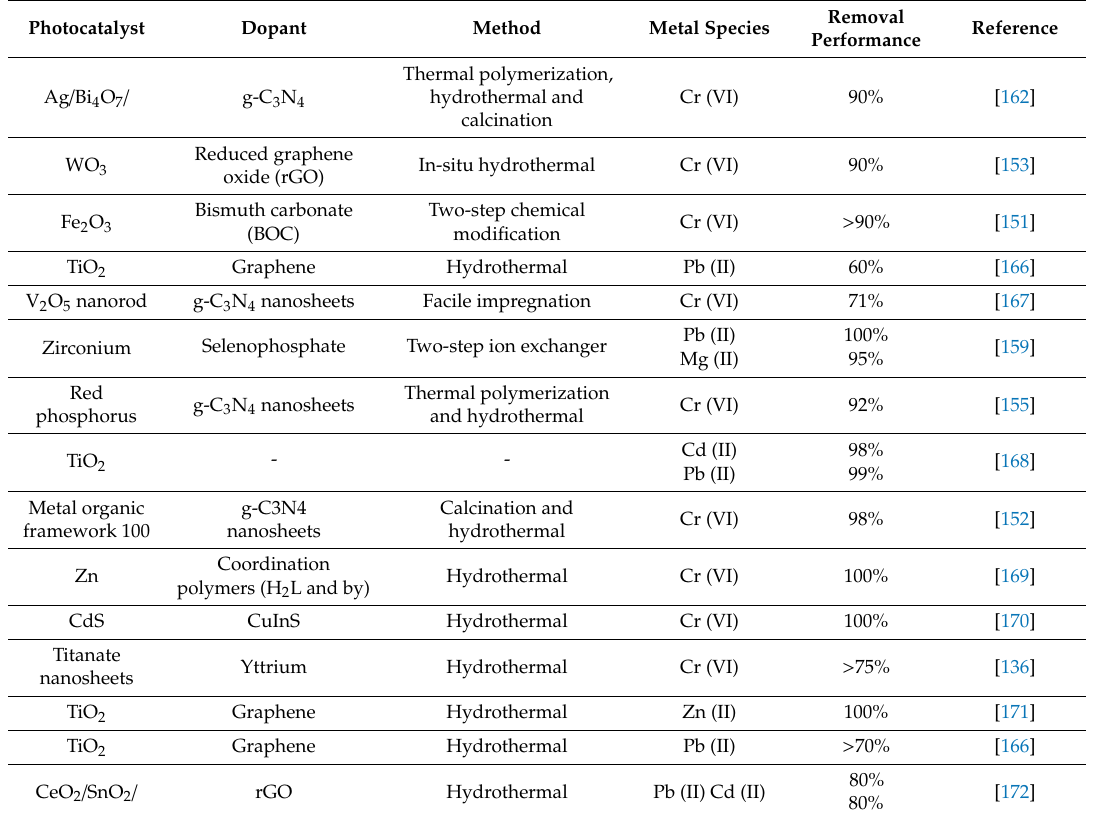
Table 5. Development of nanocomposite photocatalyst for the reduction of various types of HM. Photocatalyst